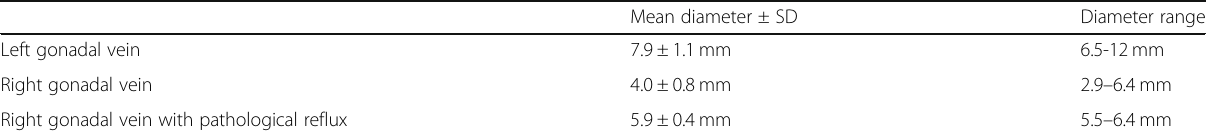
Table 2 Demonstrating the mean diameter ± standard deviation (SD) and the diameter range measured in millimeters (mm) for the left gonadal vein, right gonadal vein and for the right gonadal vein with pathological reflux Left gonadal